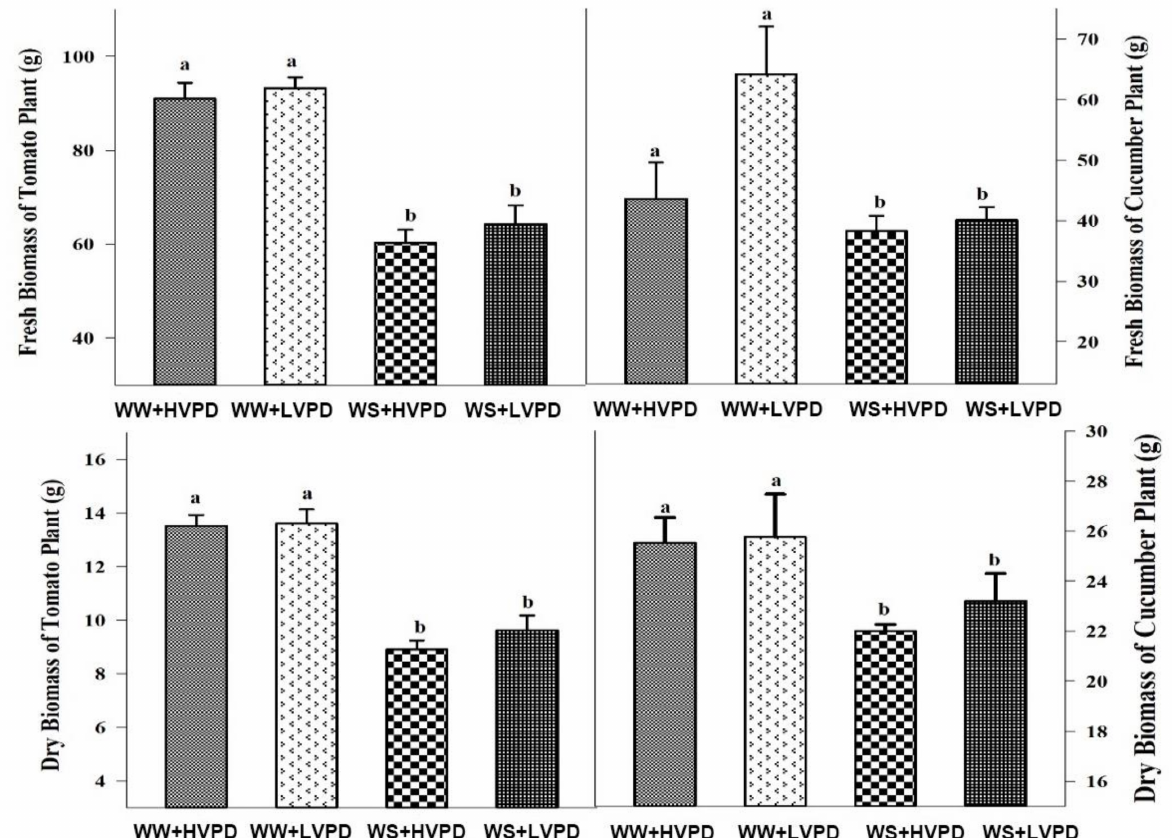
Figure 6. Effects of VPD and soil moisture on the fresh and dry biomasses of tomato and cucumber plants. Data are presented as means ± standard error ( n = 10). Letters represent significant differences between treatments. Different letters indicate significant differences ( p < 0.05). WW (well-watered, 100%FC) + HVPD (high vapor pressure deficit); WW (well-watered, 100%FC) + LVPD (low vapor pressure deficit); WS (water stress, 60%FC) + HVPD (high vapor pressure deficit); WS (water stress, 60%FC) + LVPD (low vapor pressure